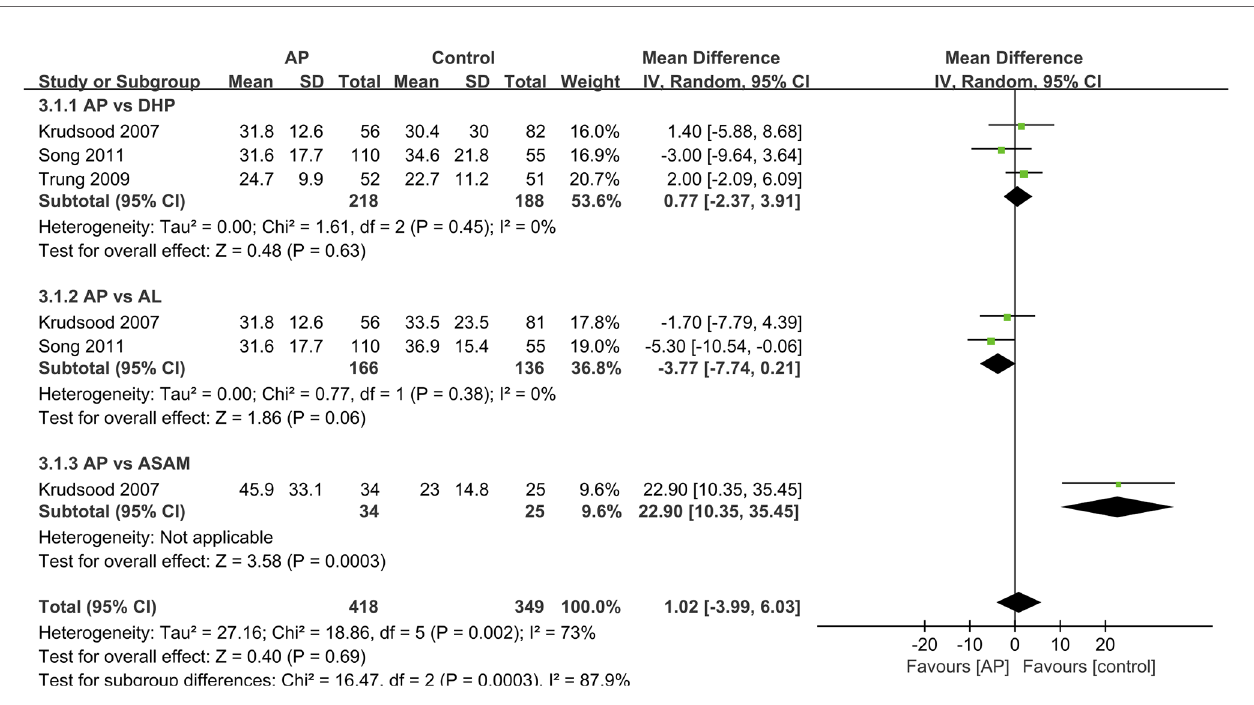
FIGURE 3 | Comparative fever clearance time (FCT) between ATQ and competing interventions.